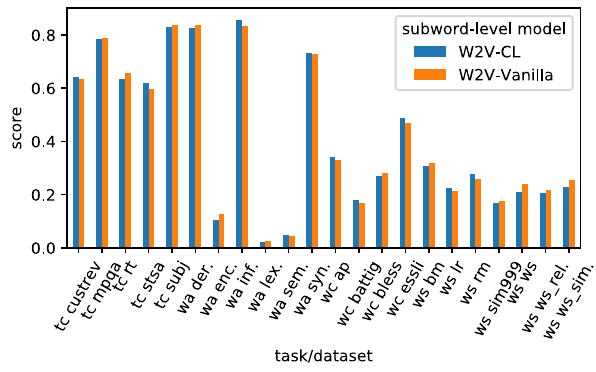
Fig. 20 Different subword-level models’ results on word similarity (ws), word analogy (wa), concept categorization (cc) and text classifi- cation (tc)